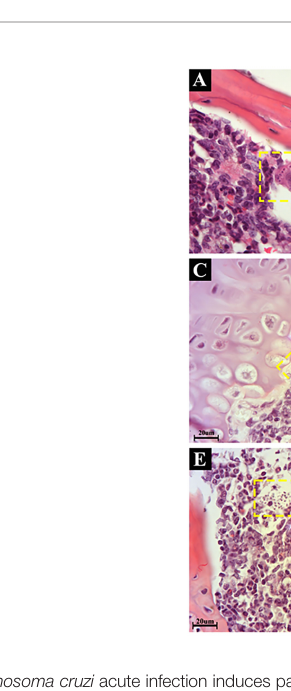
FIGURE 1 | Oral Trypanosoma cruzi acute infection induces parasitism in different sites of the bone marrow. (A , B) The microarchitecture of the mouse femur at 14 and 21 dp, showing amastigote forms of the parasite in stromal cells (yellow dashed rectangles) near the bone spicula. The Insert shows an infected cell in higher magni fi cation. (C) The histological pro fi le of the femur from one infected mouse at 14 dpi showing parasitism in the cartilage – bone intersection (yellow dashed rectangle). (D) Histology of the humerus of an infected mouse at 21 dpi, in which amastigotes in the perivascular space and near bone spicule can be seen. (E) A histological section of the humerus from an infected mouse at 21 dpi showing amastigote forms in bone marrow stromal cells. (F) Histology of the humerus from an infected mouse at 21 dpi, revealed in the inset as elongated forms with typical kinetoplasts (red arrows) and amastigote forms of the parasite within bone marrow microenvironmental cells (black arrows). Tissue sections were stained by H&E. The data are representative of 5 mice per group, 14 and 21 dpi. Bars show the magni fi cation of each micrograph in each panel, as well as